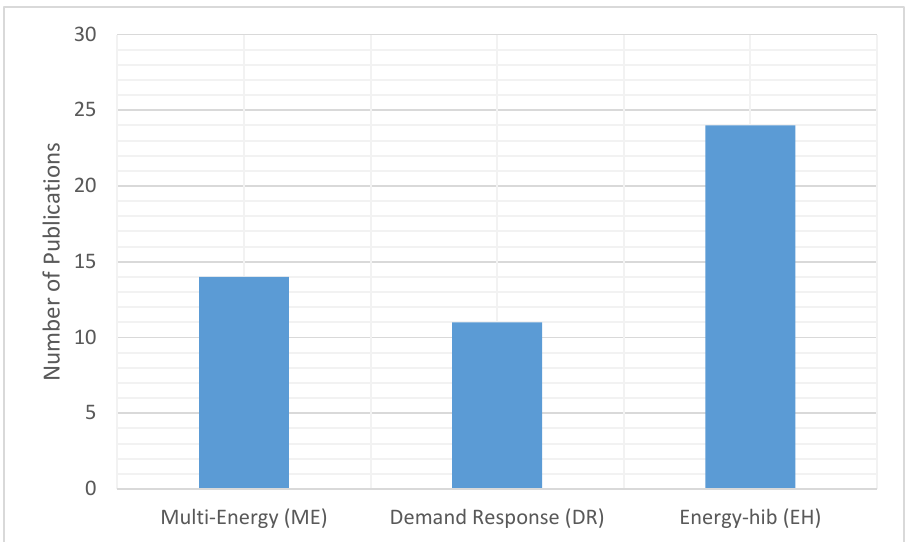
Figure 7. The main area of the works in Table 1